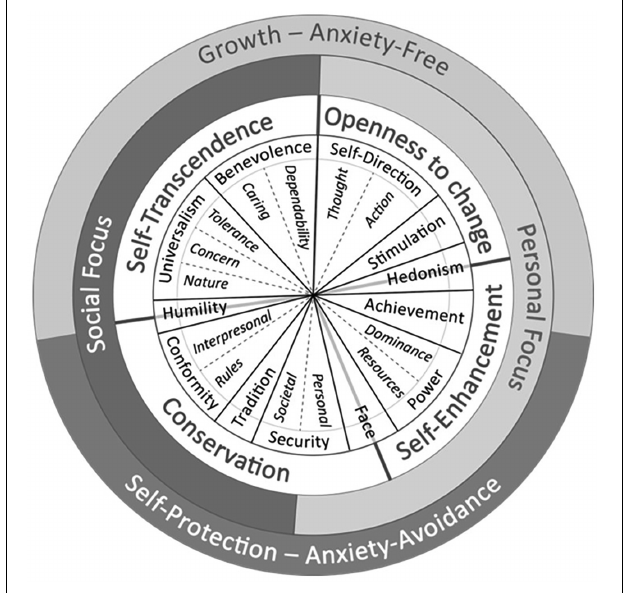
FIGURE 1 | The circular motivational continuum of 19 values in the refined value theory (from Schwartz et al., 2017).